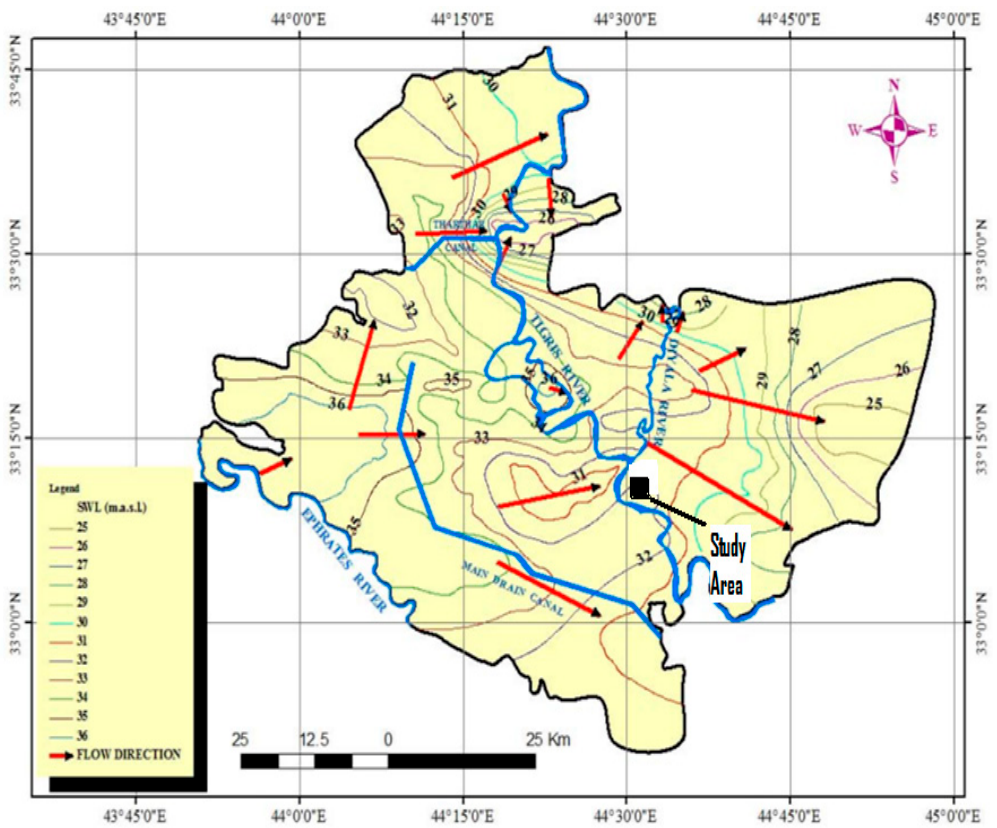
Figure 3. The directions and water levels of groundwater flow, Baghdad city.